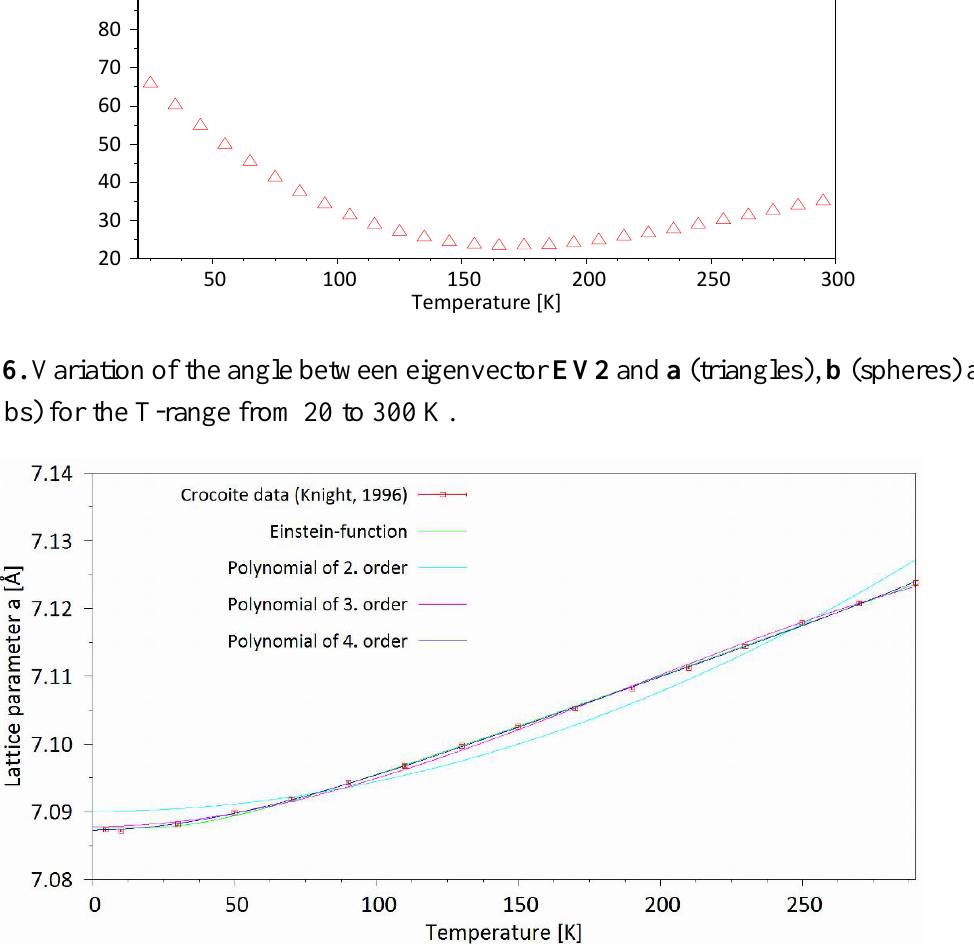
Figure 7. Comparison between an Einstein-type function and polynomials of order two, three and four for the modeling of the low-temperature behavior of the a lattice parameter of crocoite (PbCrO 4